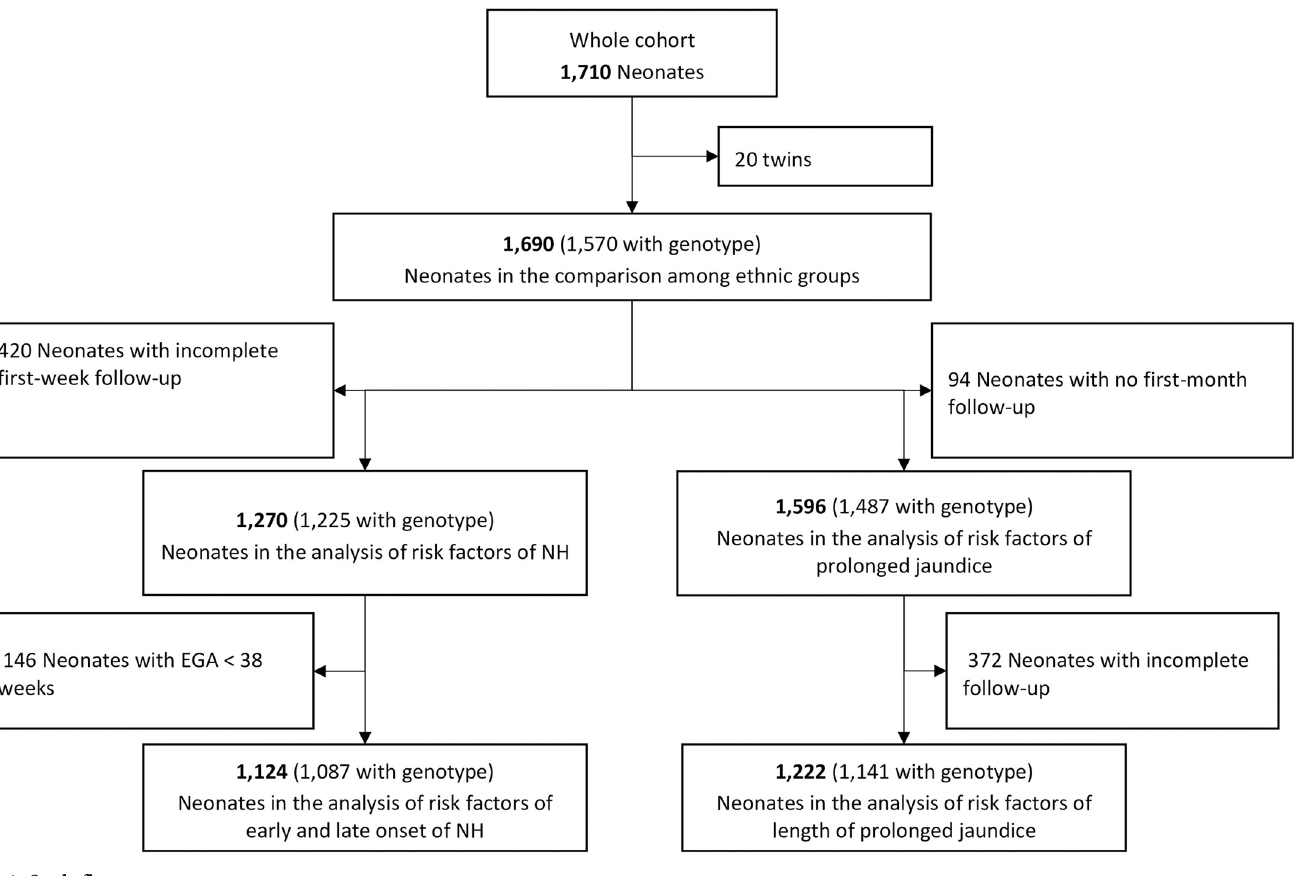
Fig 1. Study flow.